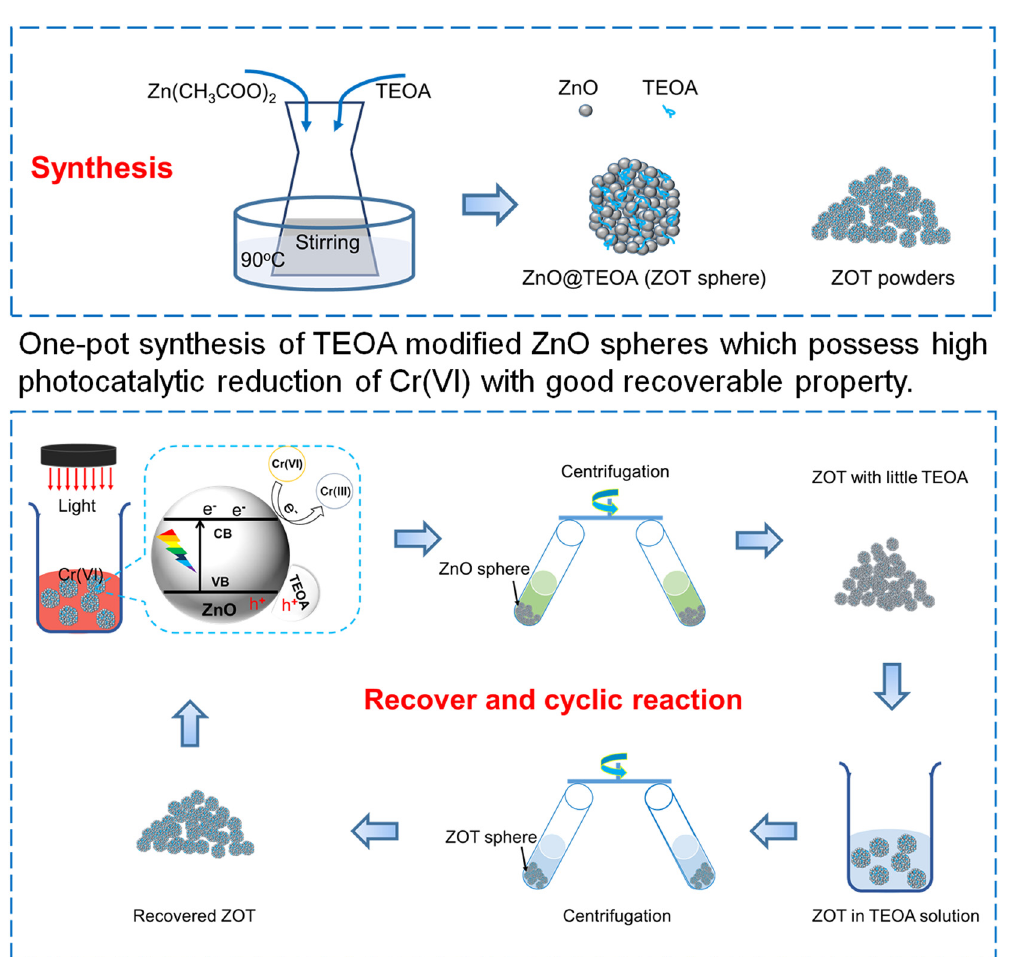
Figure 1: One - pot synthesis of TEOA - modi fi ed ZnO spheres that possess high activity for the photocatalytic reduction of Cr ( VI ) and good recoverable